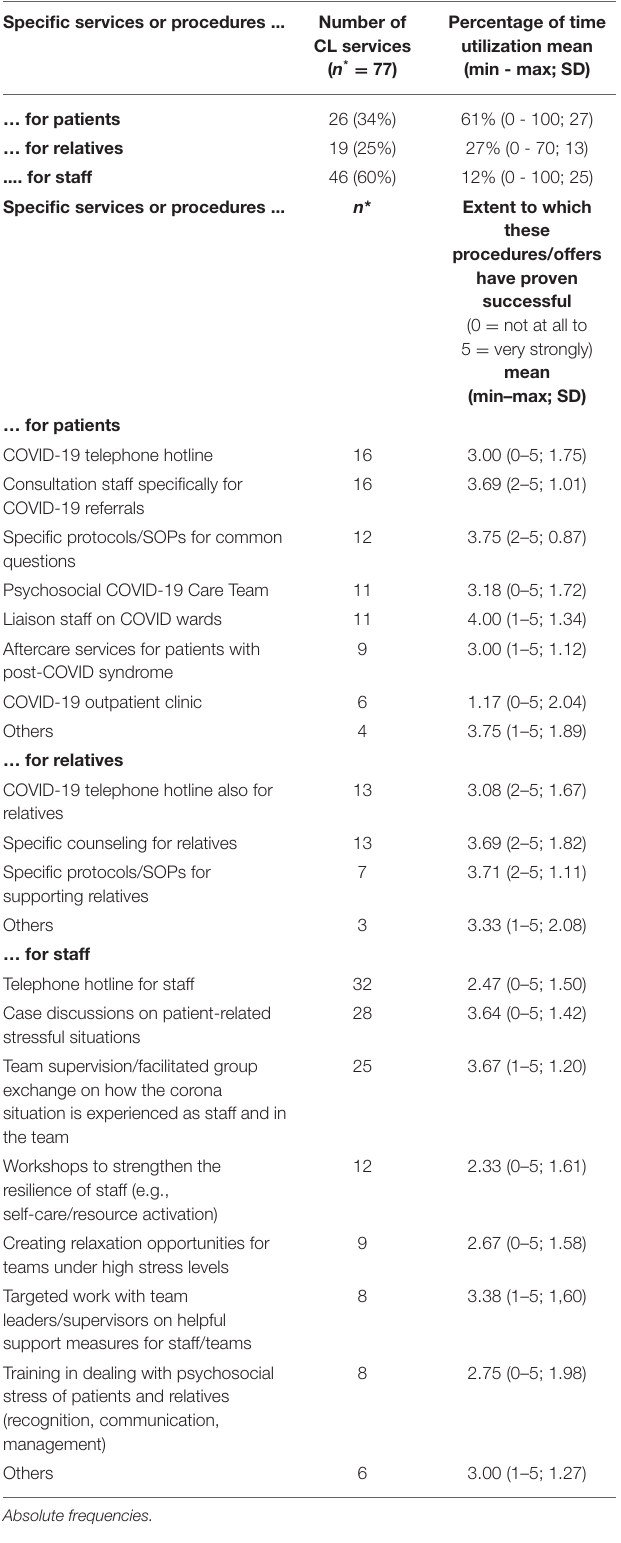
TABLE 2 | Specific services or procedures of COVID-psyCare offered by the CL services providing COVID-psyCare ( n = 77). Specific services or procedures ...